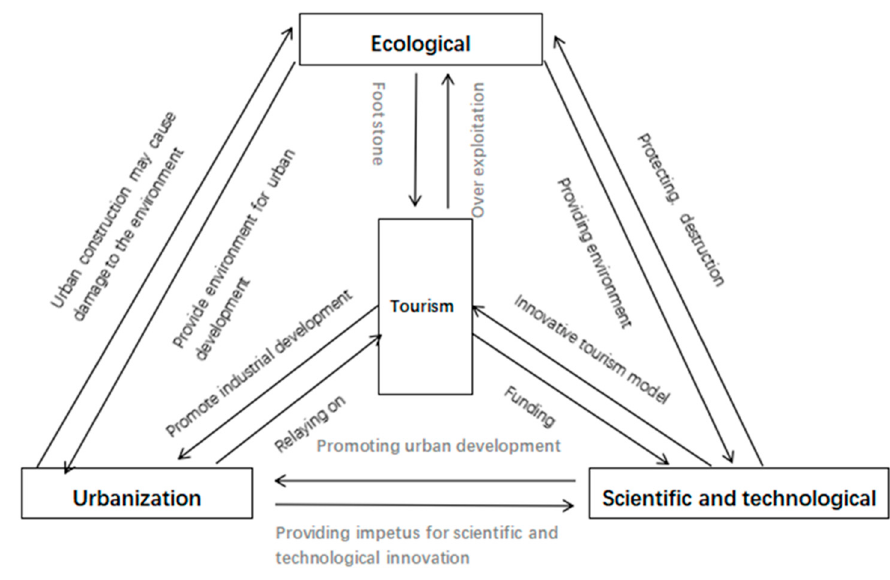
Figure 1. The uncoordinated coupling mechanism.